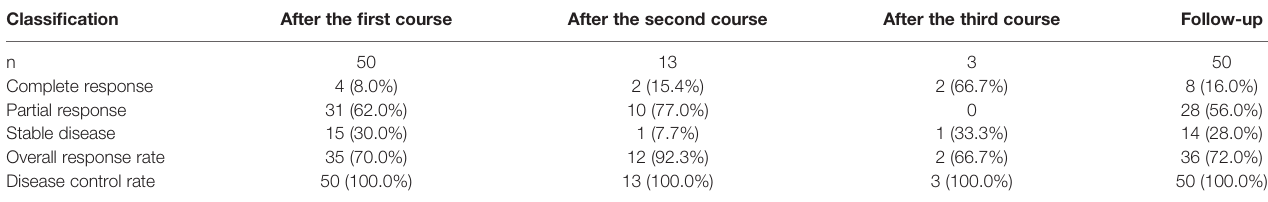
TABLE 4 | Clinical ef fi cacy after arterial infusion chemotherapy.